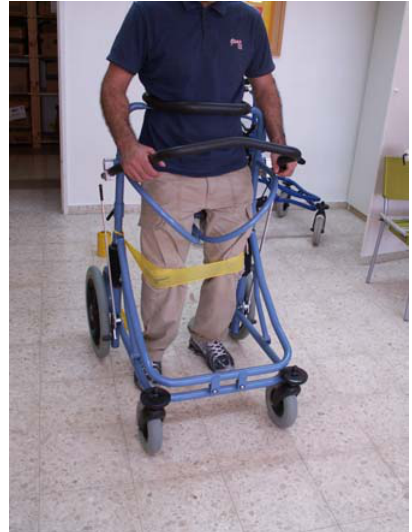
PICTURE 24 . The use of elastic bands to enhance